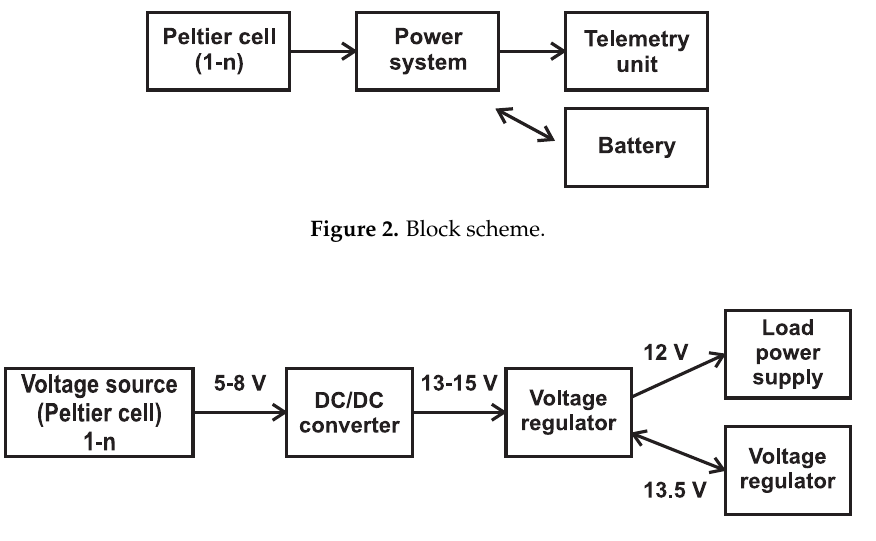
Figure 3. Block scheme of power supply